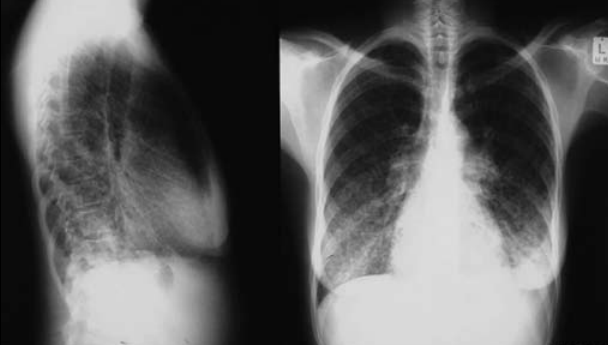
Fig. 2. Frontal and lateral radiographs of an adult female patient demonstrate predominantly nodular infiltrate distributed in the basal lung zones with hilar adenopathy and left pleural effusion.